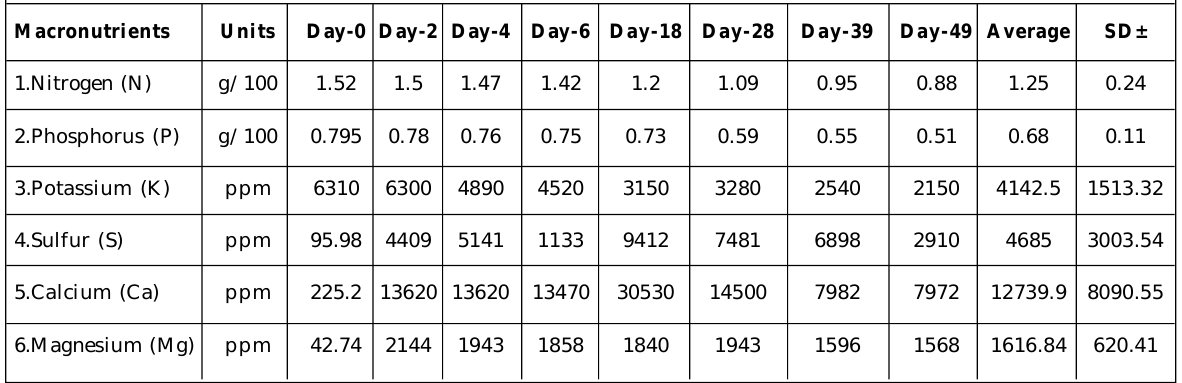
Table 3: Variation trend of macronutrients during composting and WBM cultivation Macronutrients